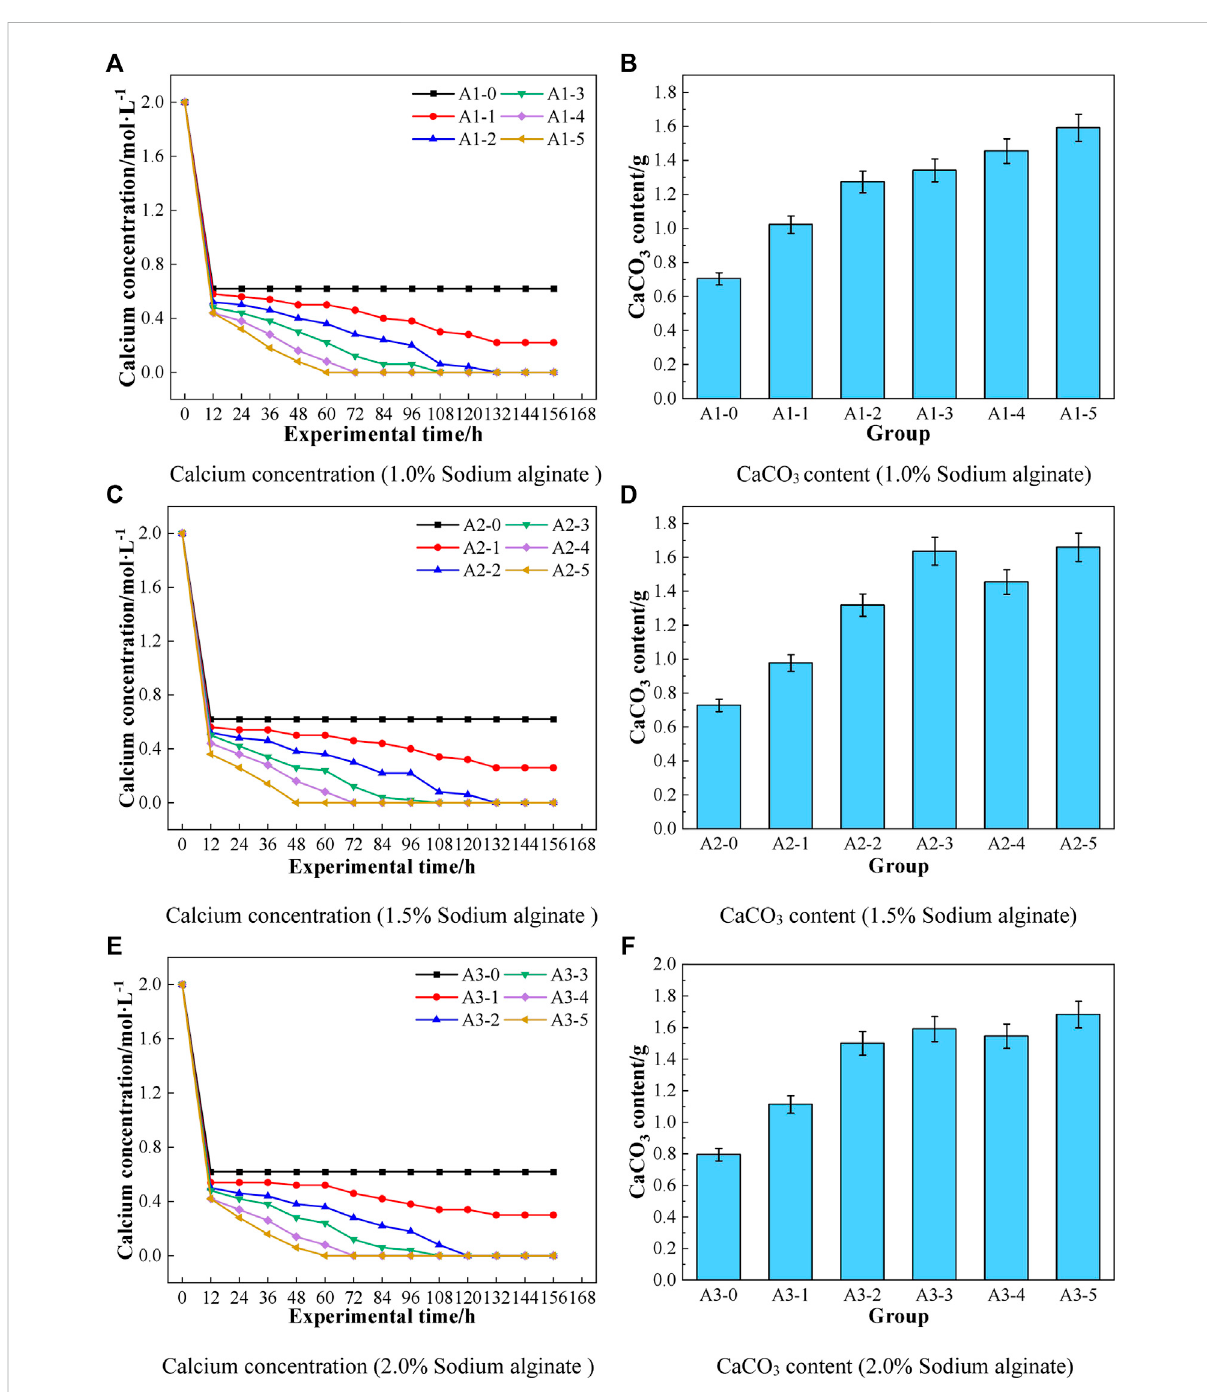
FIGURE 4 EffectofsodiumalginateonCaCO 3 contentofmicrobialrepairmaterials[ (A) Calciumconcentration(1.0%Sodiumalginate), (B) CaCO 3